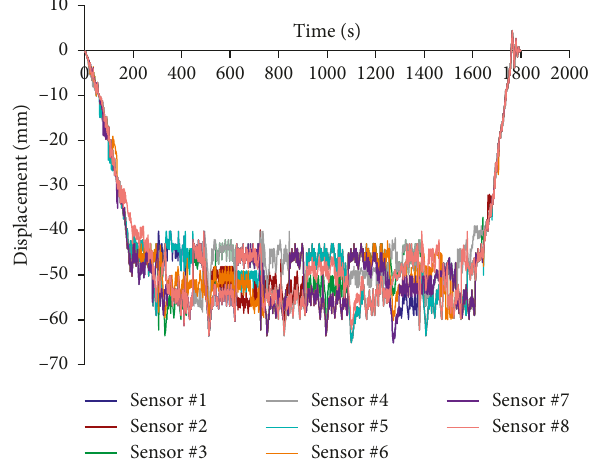
Figure 14: Time-varying change curve of buffering device